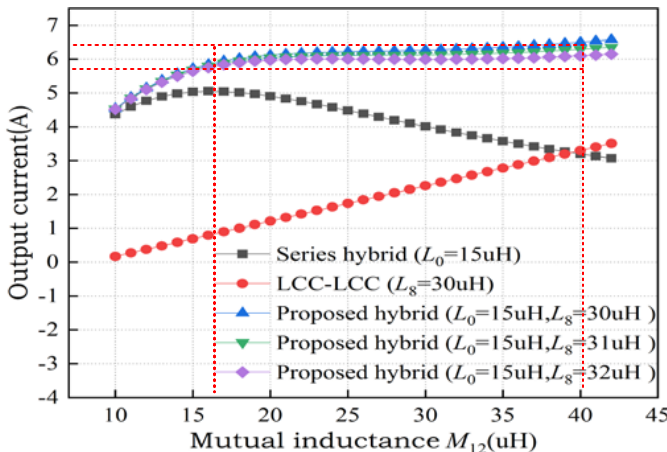
Figure 11. Output current of the proposed hybrid system .